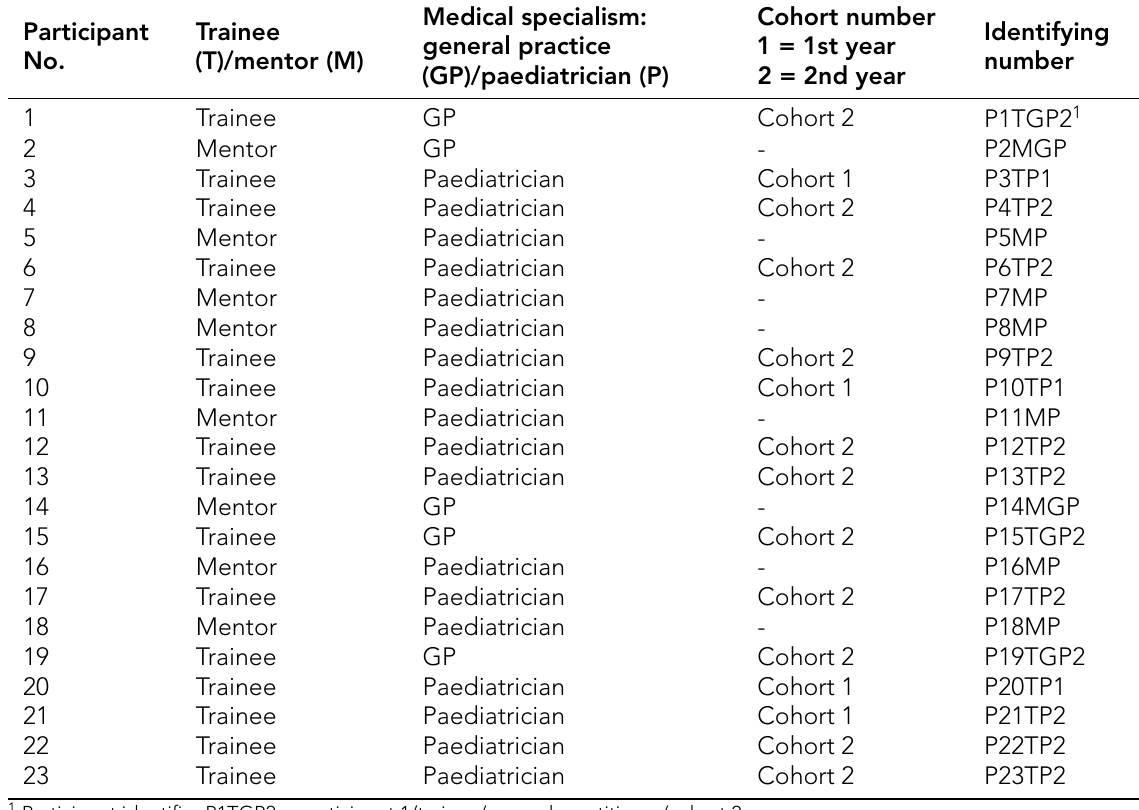
Medical specialism: general practice